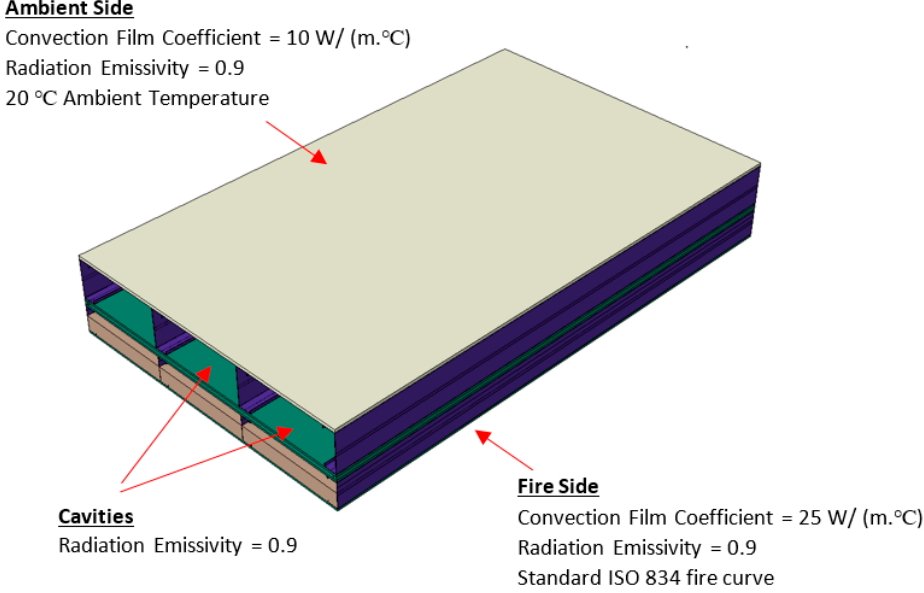
Figure 4. Interactions and boundary conditions on FEM of M_SP_90RW floor system.